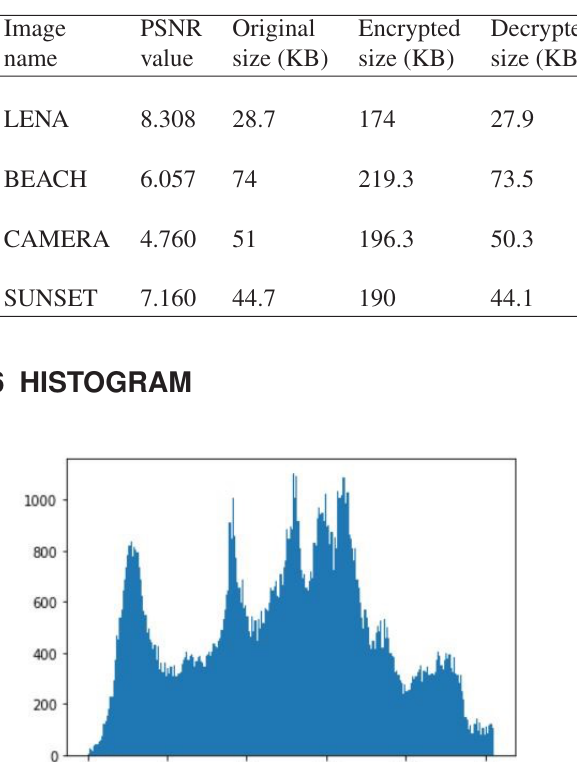
Figure 7. Original image of Lena - size 28.7 KB